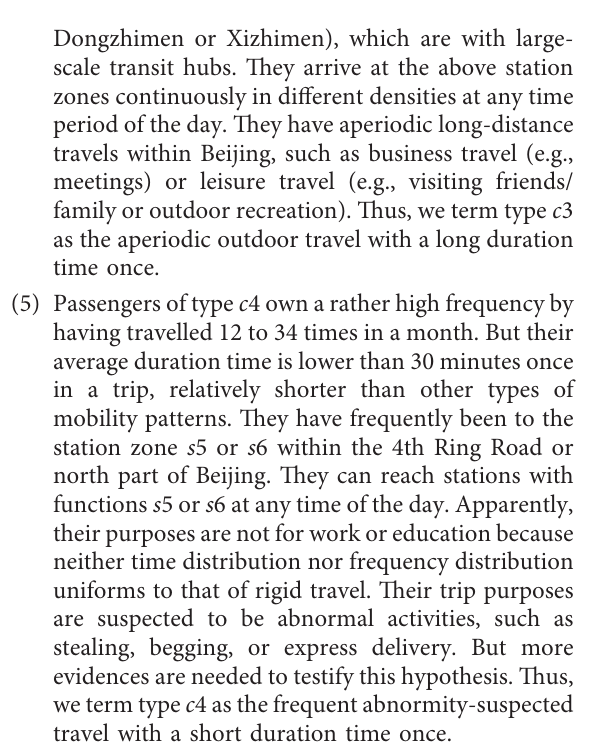
Figure 10: Spatiotemporal distribution of passengers’ dependency levels regarding station functions: (a) c 0, (b) c 1, (c) c 2, (d) c 3, and (e) c 4